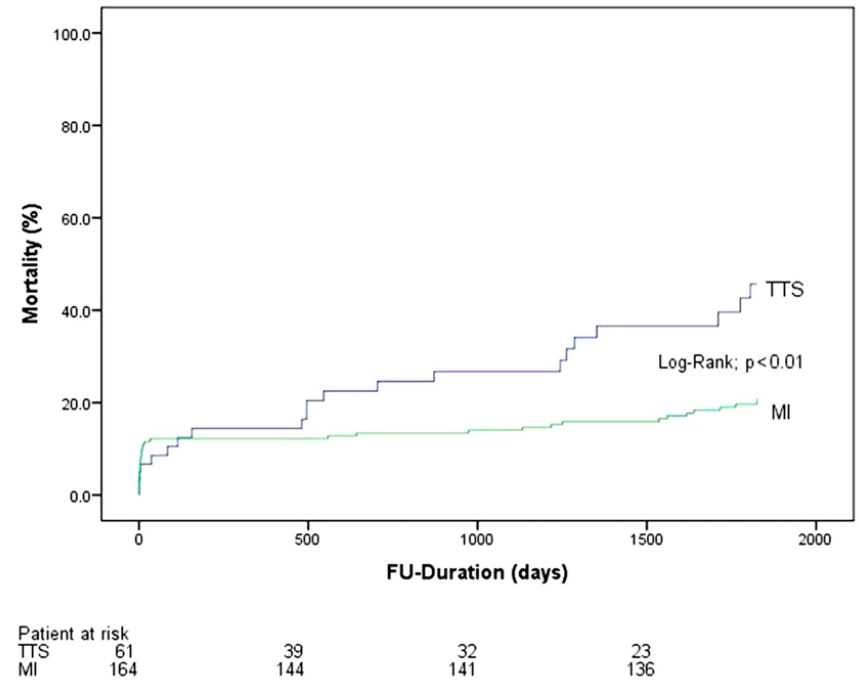
Figure 2. Mortality rate in patients suffering from takotsubo cardiomyopathy (TTS) and KF compared to patients with MI and kidney failure at five-year follow-up.